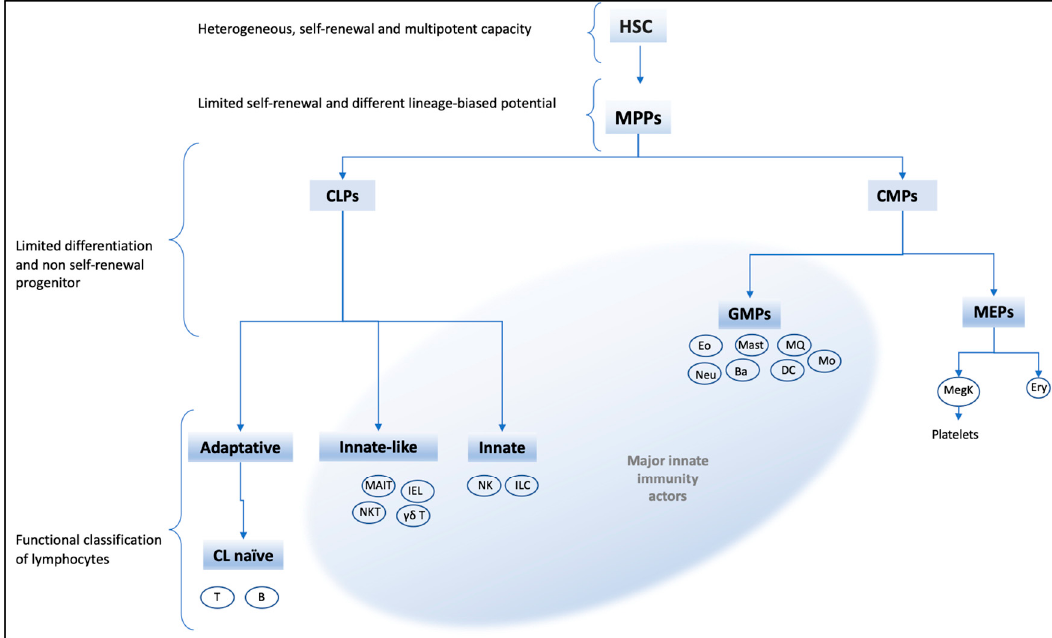
Figure 4. Hematopoietic hierarchy adapted with a functional classification of